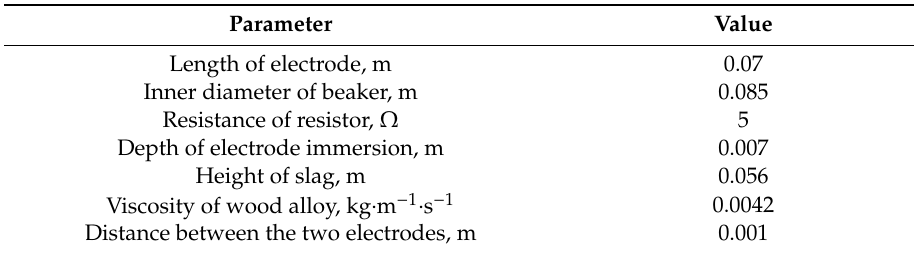
Table 2. Parameters of physical